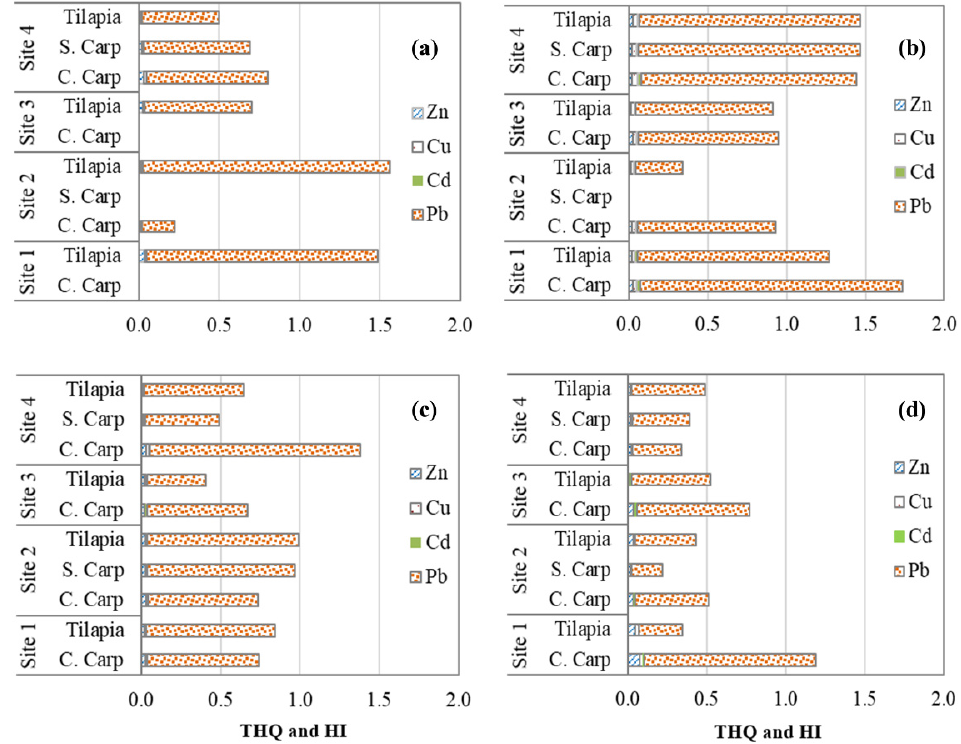
Figure 5. Seasonal and spatial target hazard quotient (THQ) and total hazard index (HI) of four metals in fish collected from four research sites: ( a ) Spring, ( b ) Summer, ( c ) Autumn, and ( d ) Winter. TR values for Pb ranged from 4.0 × 10 − 7 to 3.4 × 10 − 6 , indicating a potential carcinogenic HI was calculated by considering the total effects of four metals in fish (Equation